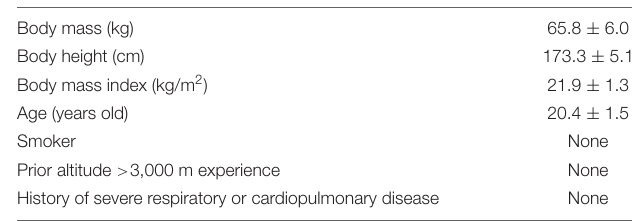
TABLE 1 | Characteristics of